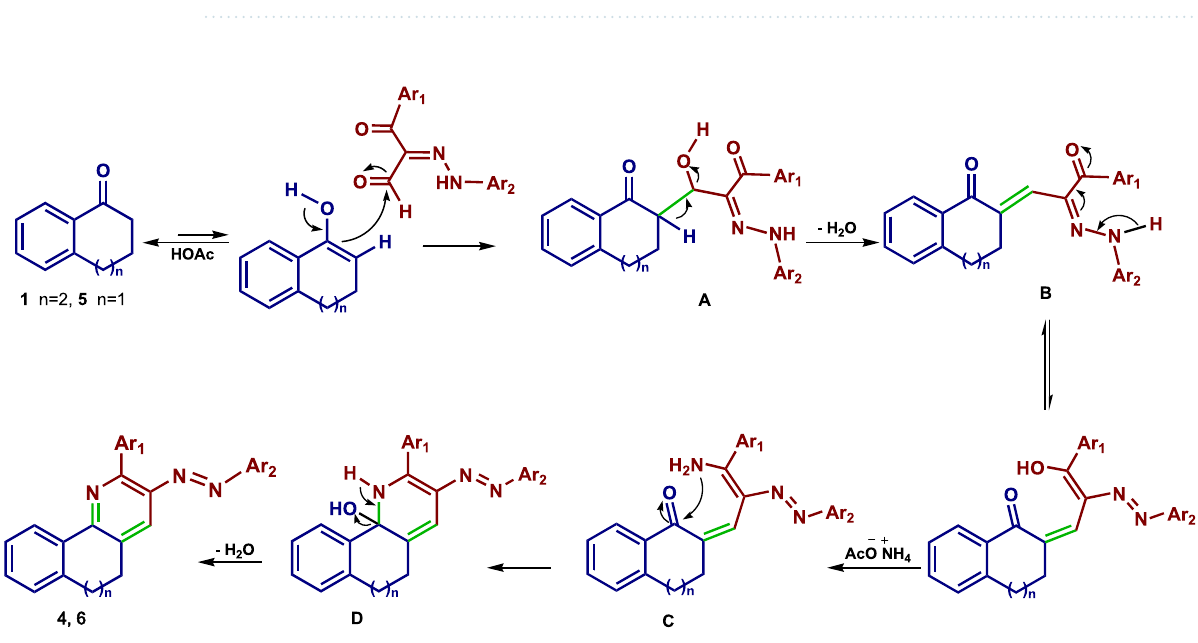
Scheme 2. Mechanistic pathway postulated for the formation of compounds 4 and 6